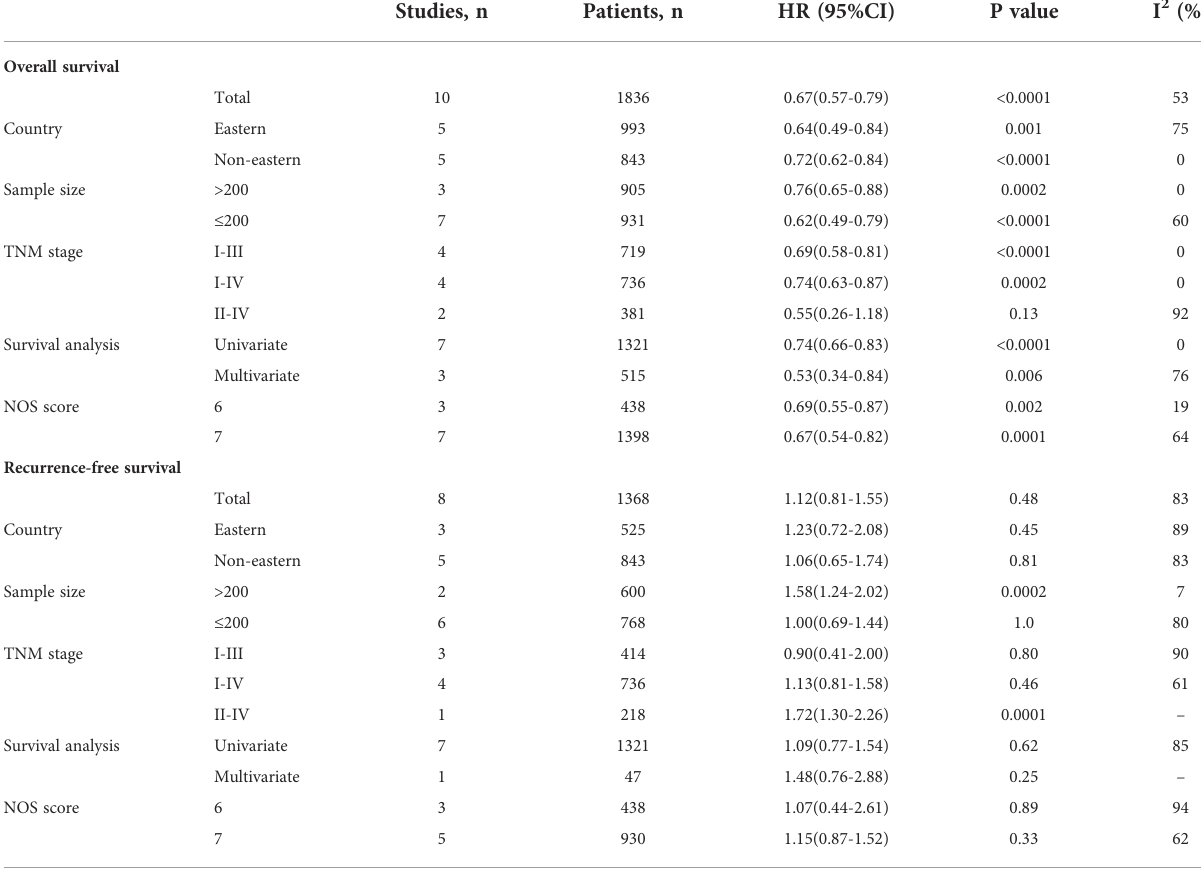
TABLE 3 Subgroup analysis for overall survival and recurrence-free survival of AR patients vs. SR patients.